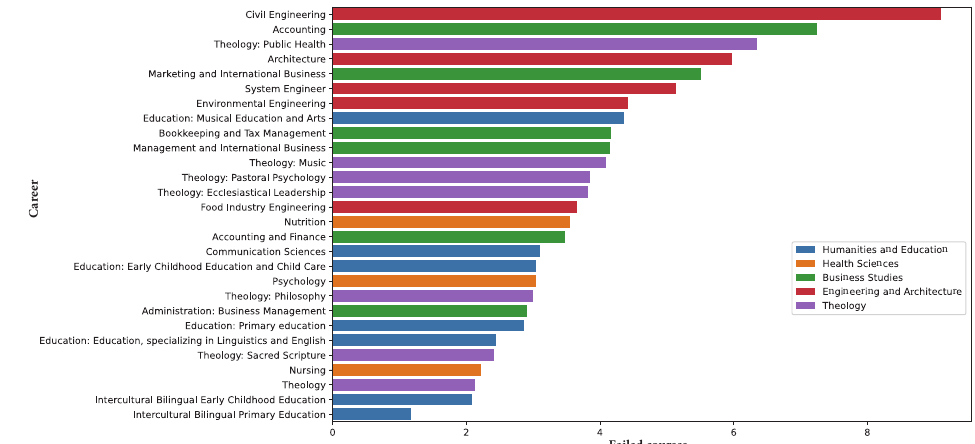
Figure 4. Average number of Failed Courses according to professional career and faculty.